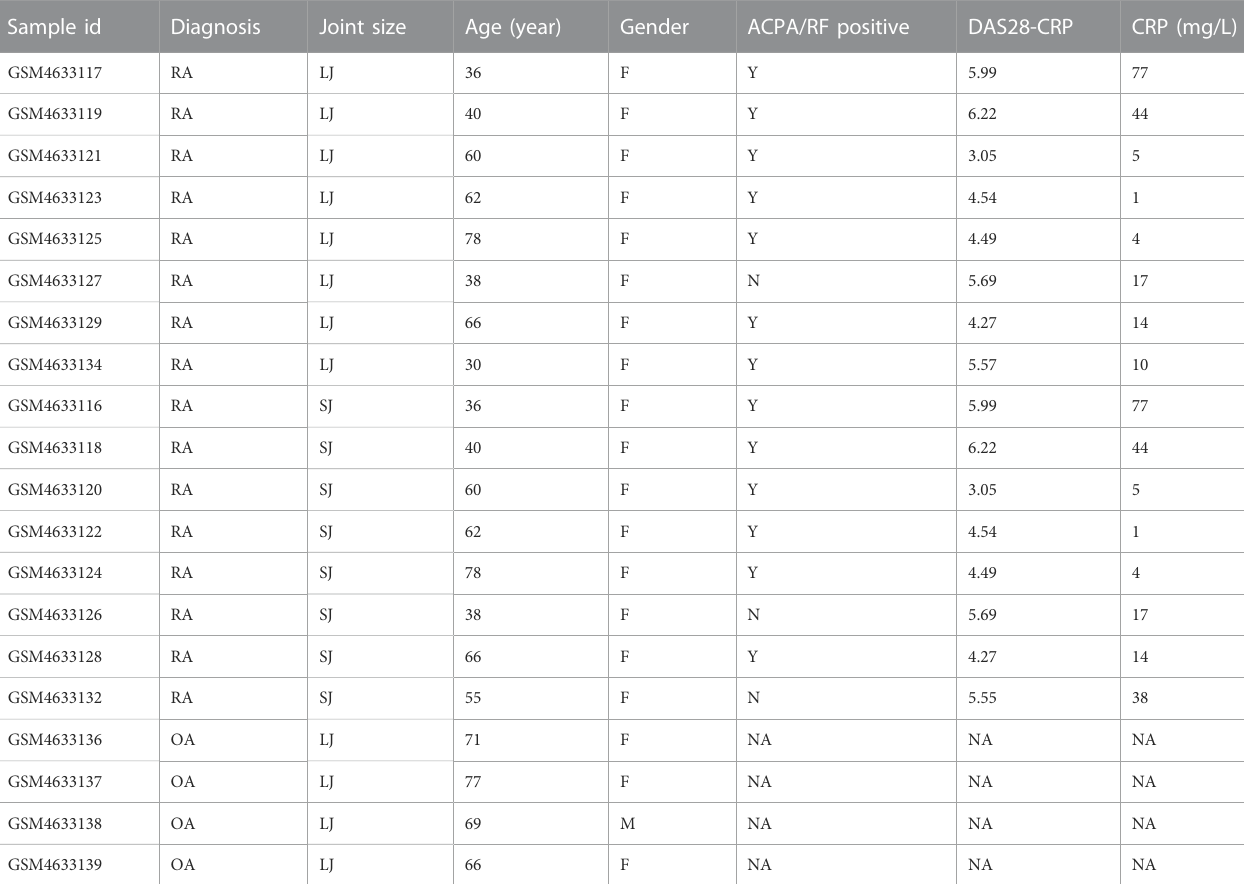
TABLE 1 Characteristics of the samples in this